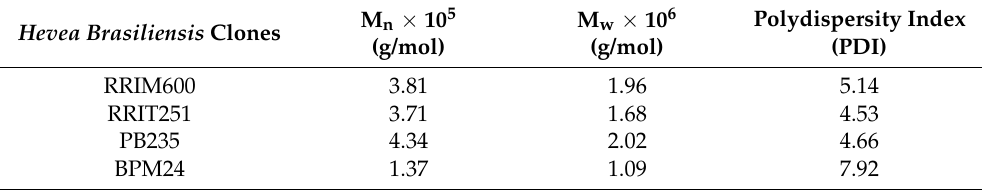
Table 4. Molecular weight and polydispersity index of fresh natural latex from four different Hevea brasiliensis